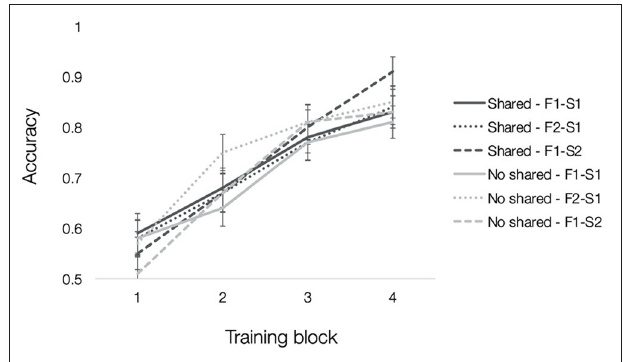
FIGURE 3 | Experiment 1 training accuracy. Mean accuracy from each block of training separated by trained association type (F1-S1 solid lines, F2-S1 dotted lines, F1-S2 dashed lines) and pair-mate type (shared parent in dark gray, no shared parent in light gray). Error bars depict the standard error of the mean across